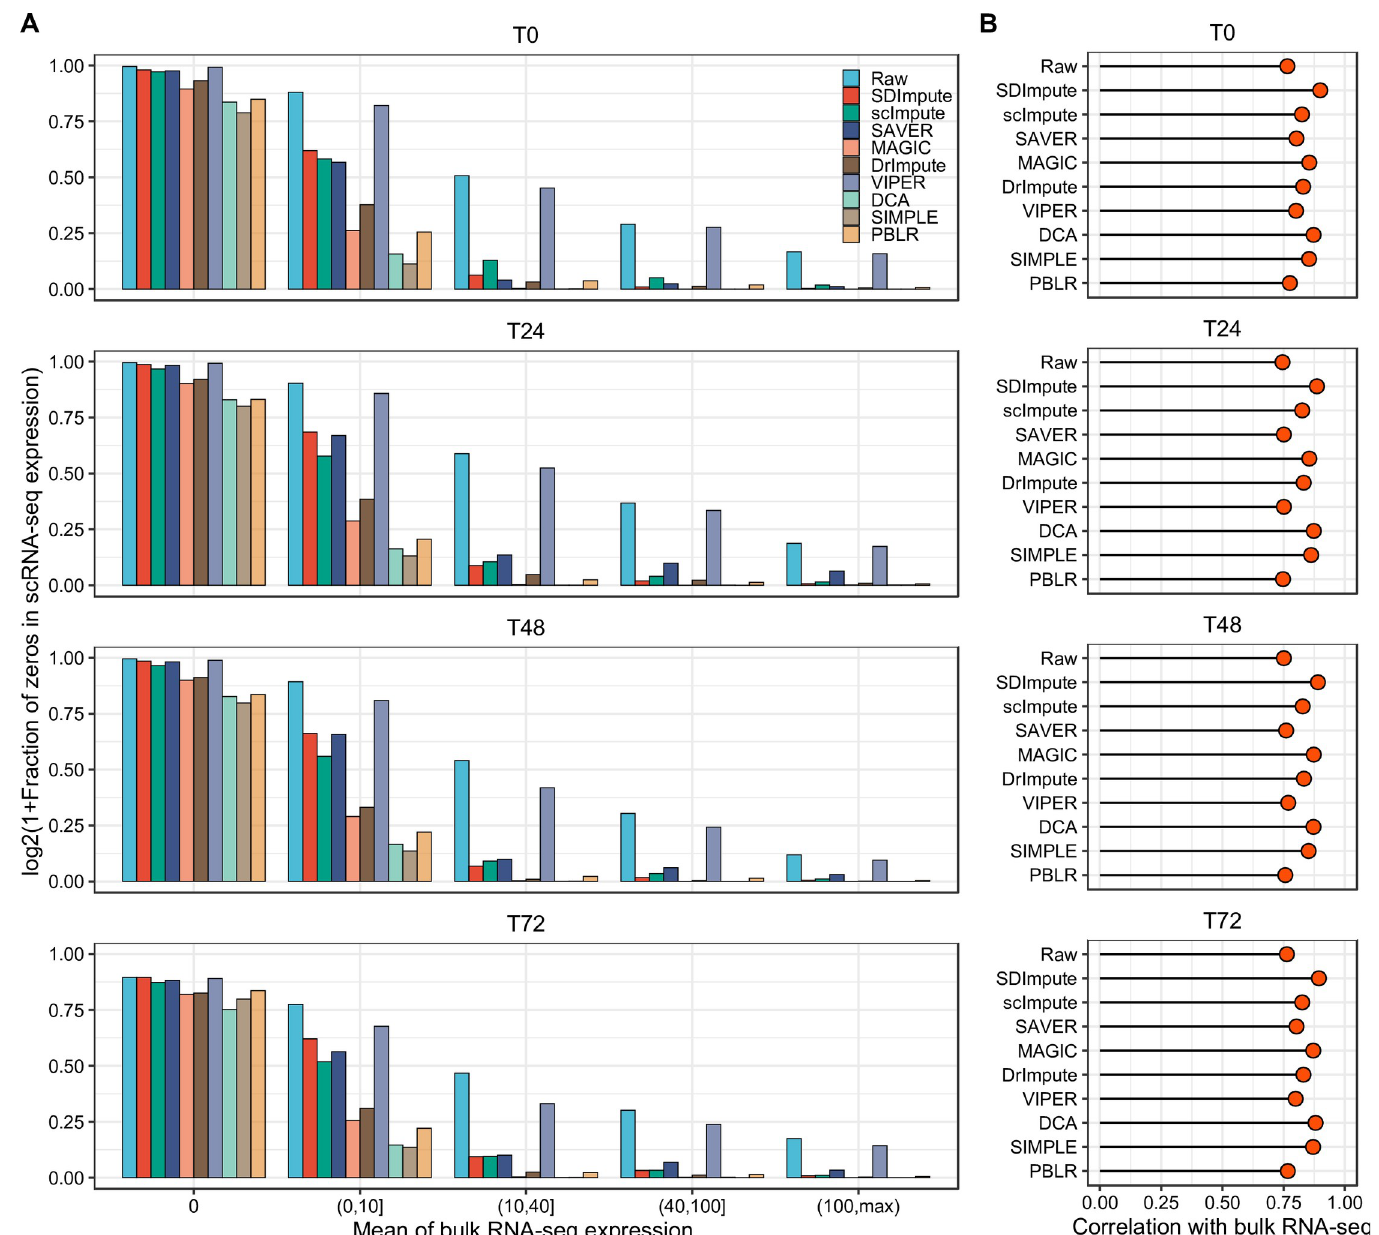
Fig 1. SDImpute imputes dropouts and retains true zeros in the Trapnell dataset. (A) The plots show the fraction of zero counts in scRNA-seq data against the mean of bulk expression entries across sample replicates of T0, T24, T36, and T72, respectively. The expression values are divided into five bins based on the mean of bulk gene expression entries of sample replicates. (B) Results of the Pearson Correlation between average expression levels of the same cell type in the imputed scRNA-seq data and the mean of the bulk RNA-seq dataset across sample replicates of T0, T24, T36, and T72, respectively.